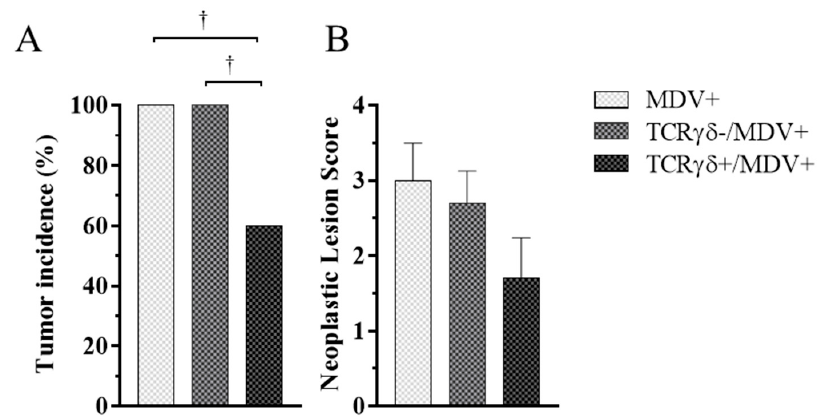
Figure 3. Tumor incidence and neoplastic lesion scores at 21 days post-cell infusion and MDV challenge. TCR γδ -activated or -unactivated PBMCs were infused to recipient chickens at 21-days-old, and the chickens were challenged with MDV. Tumor incidence ( A ) and neoplastic lesion scores ( B ) were determined by necropsy in the MDV+, the TCR γδ -/MDV+, and the TCR γδ +/MDV+ groups at 21 dpi. Tumor scores were assessed by the number of tumor-bearing organs. Data of the neoplastic lesion scores represent the mean of 10 biological replicates ± SE in each group. Significant differences are indicated by †: p < 0.05.